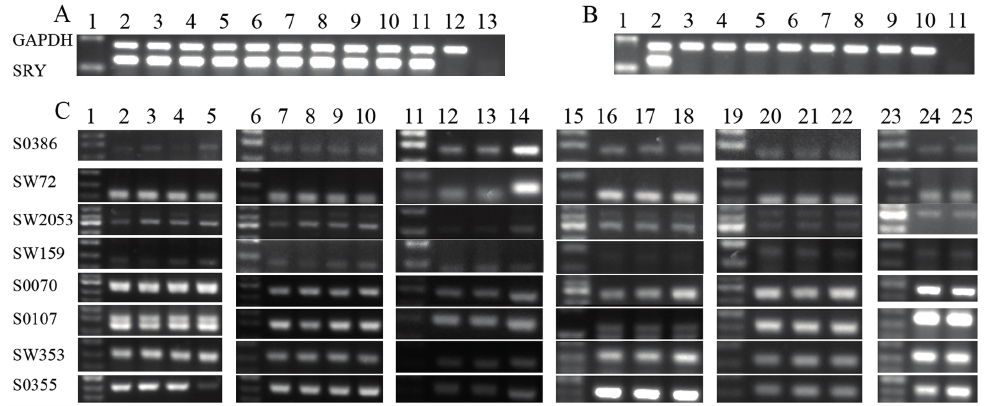
Figure 1. Genotypic identification of aborted fetuses by PCR